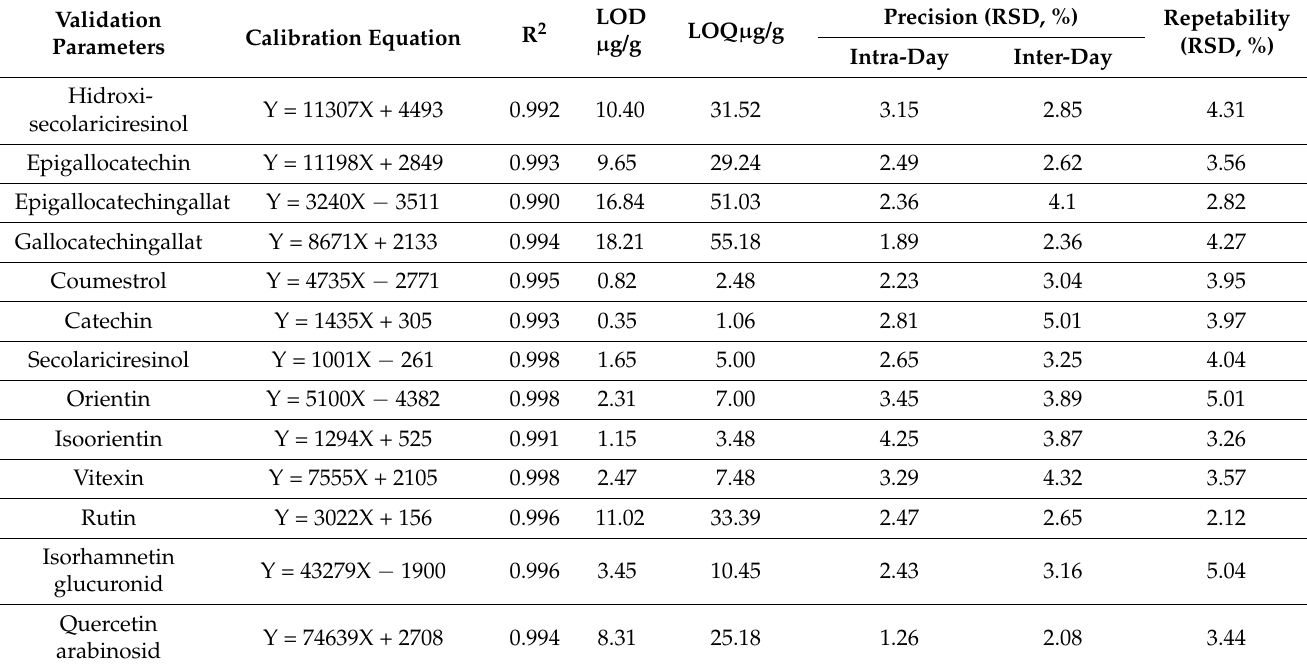
Table 3. Analytical performances of the method used for the quantification of individual flavonoid compounds in buckwheat seeds, and after 3 and 7 days of